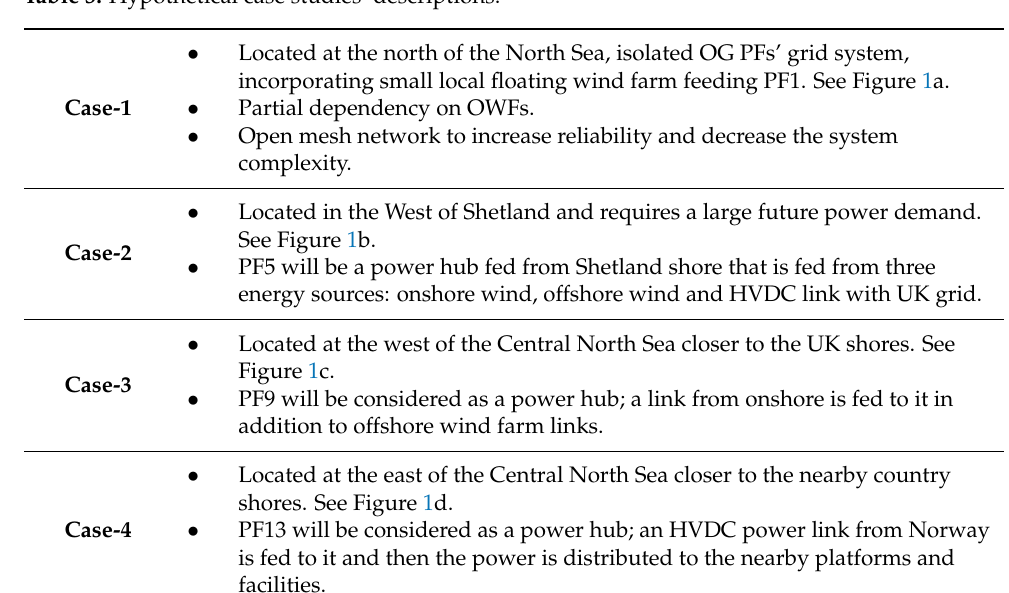
Table 3. Hypothetical case studies’ descriptions.